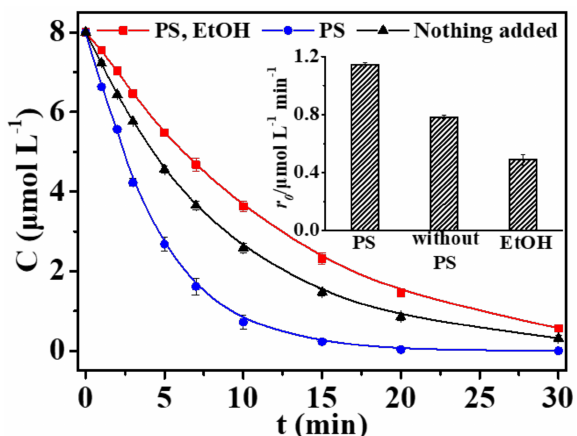
Figure 3. Effect of different quenchers on the degradation of p -ASA in UV/PS system. Insert: the initial rate constant of p -ASA degradation ( r 0 ) on different conditions. Conditions: (EtOH) = 40 mmol L − 1